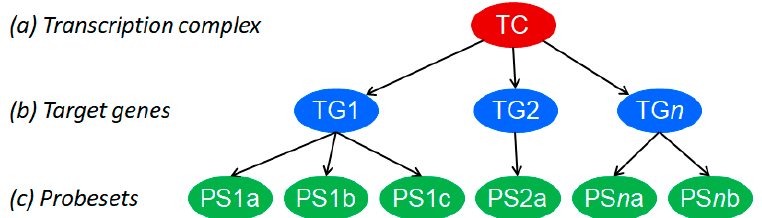
Figure 1. Knowledge-based Bayesian computational pathway model. The Bayesian network structure, used as a basis for our modeling approach and shown as a simplified model of the transcriptional program of a cellular signal transduction pathway, consists of three types of nodes: transcription factor, target gene, and microarray probe sets corresponding to the target gene. Used with permission from Reference [65].